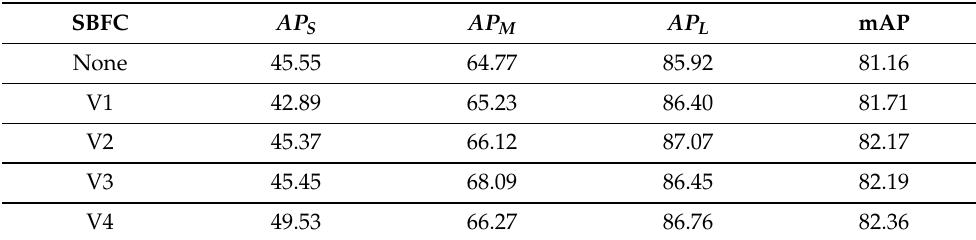
Table 3. The impact of different structure of SBFC.